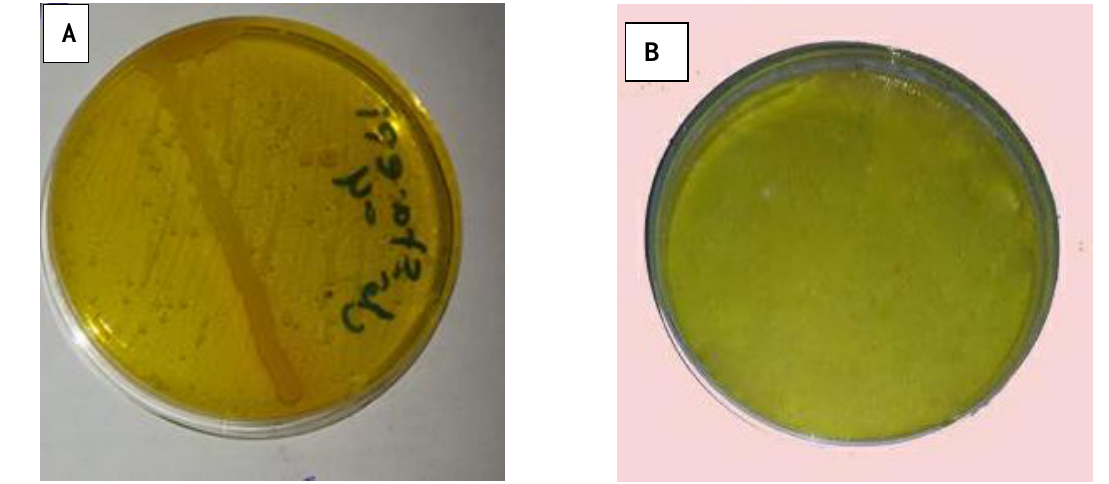
Fig.4: Staphylococcus epidermidis bacteria growth samples after exposure to plasma jet system:- A: control , B: after treatment of